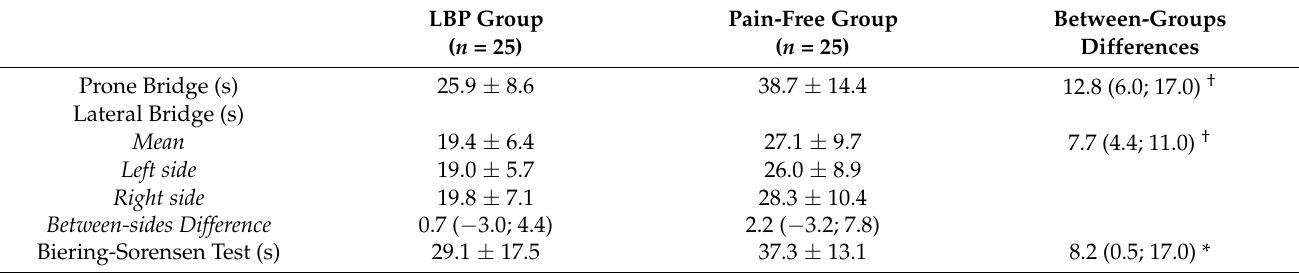
Table 4. Physical function characteristics: muscle